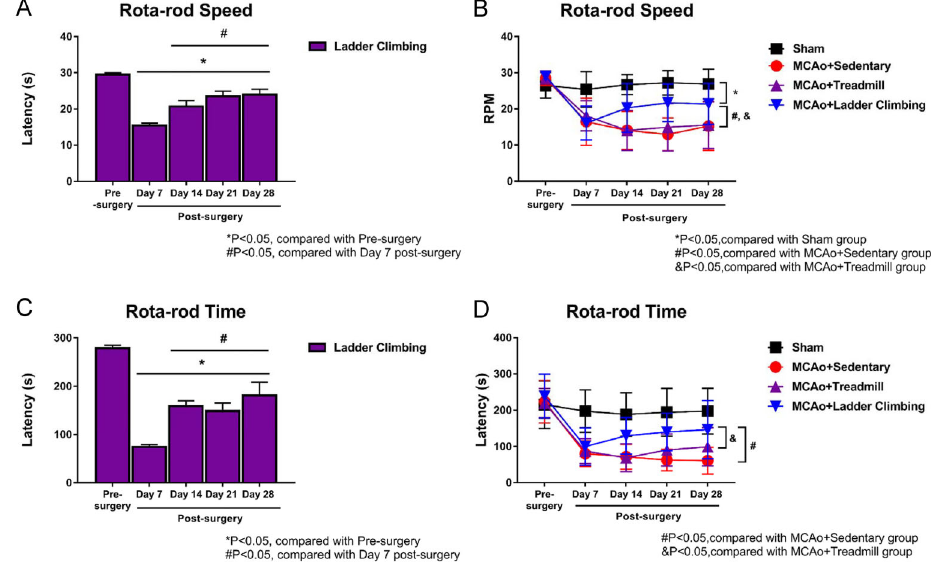
Figure 8. Rota-rod test results for 28 days after stroke rehabilitation in sham rats and rats with middle cerebral artery occlusion (MCAo) submitted to different exercise protocols. A , Weekly rota-rod speed for the ladder group. B , Average weekly rota-rod speed for each group. C , Weekly rota-rod time for the ladder group. D , Average weekly rota-rod time for each group. Data are reported as means ± SD (ANOVA and t -test).